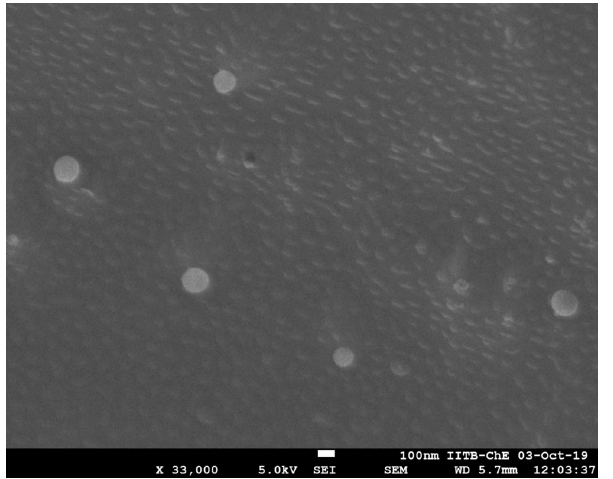
Fig 3. SEM image of stealth liposomes (CL13).